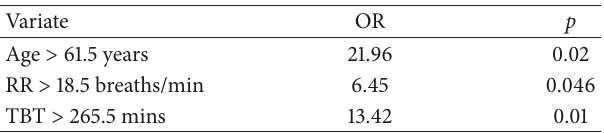
Table 6: Multivariate analysis of preoperative and operative predic- tors for hospital